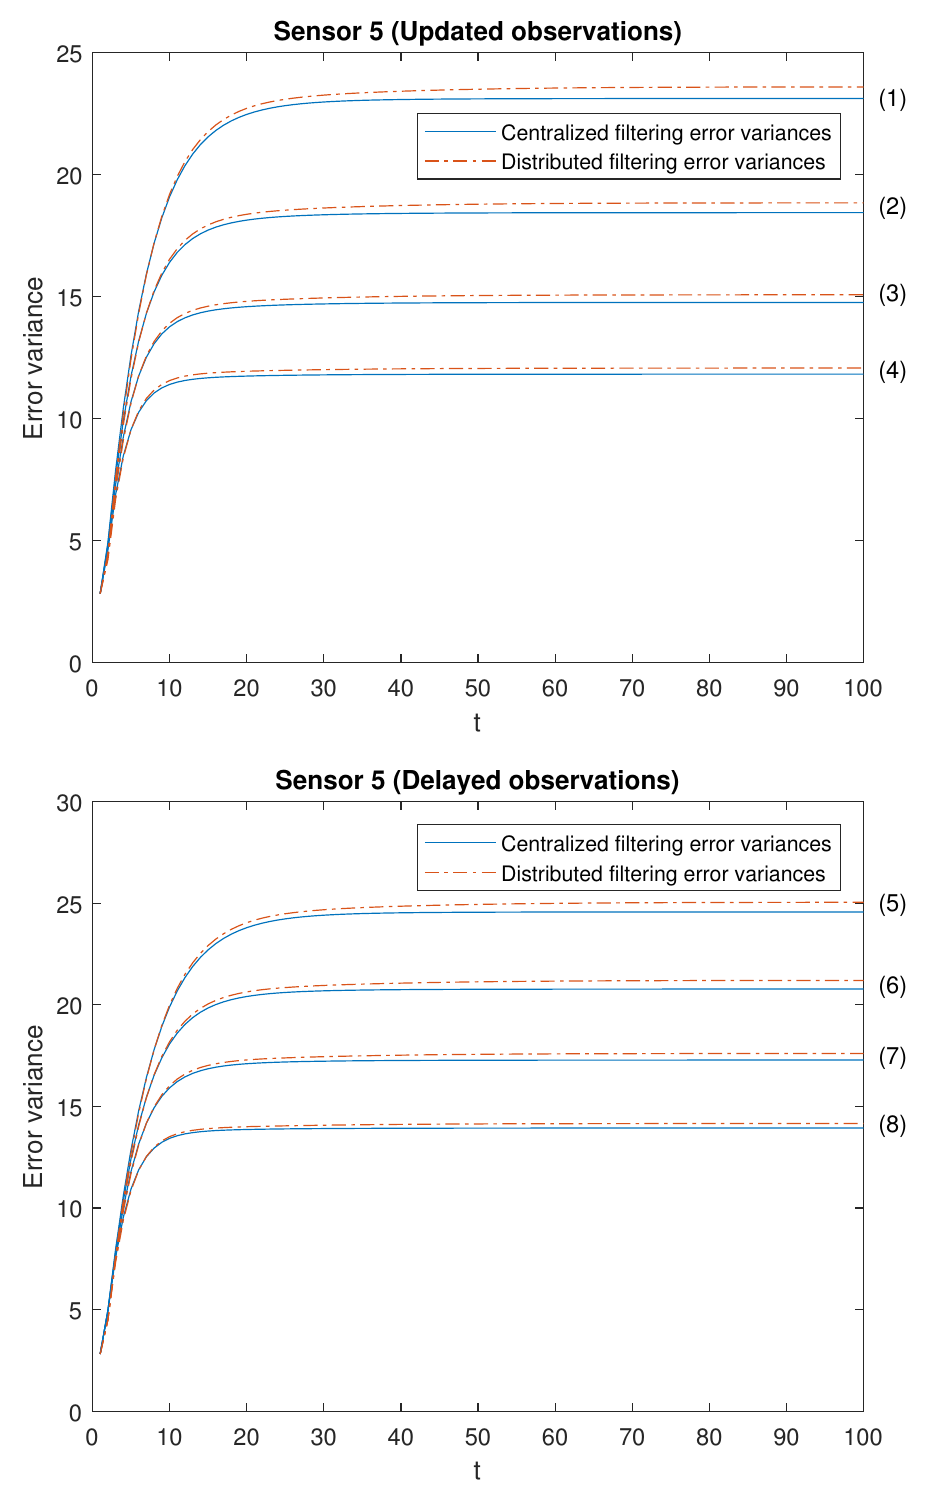
( 5 ) = 0.3, 1 = 0.9, p ( 5 ) = 0.05; 2 1